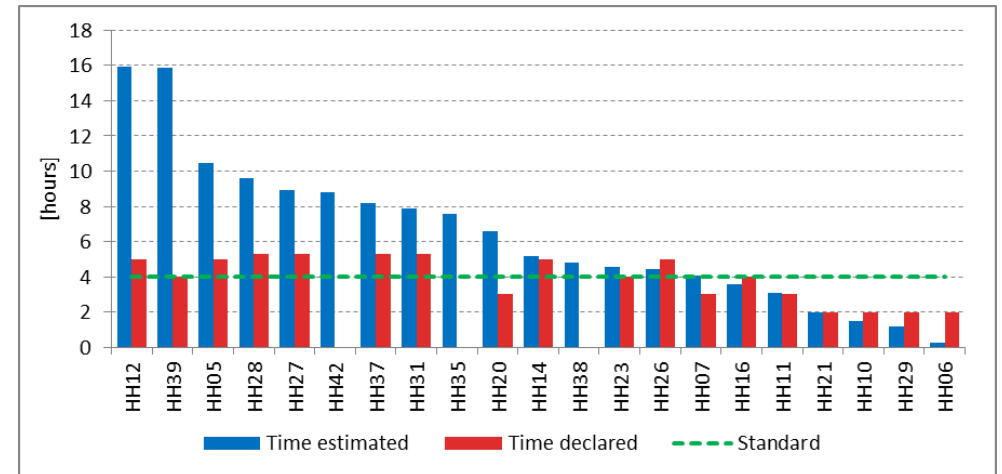
Figure 6. Comparison between estimated and declared time of usage. The standard use refers to the time considered for energy labeling.